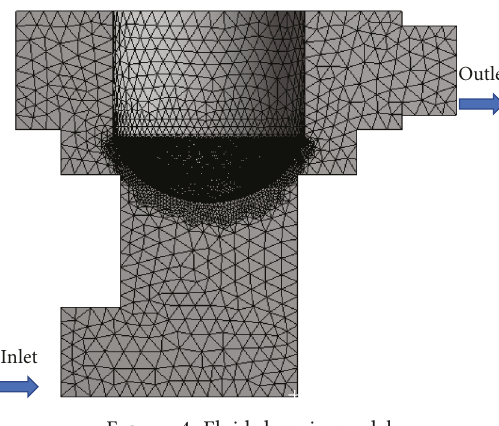
Figure 4: Fluid domain Table 1: Grid independence verification.